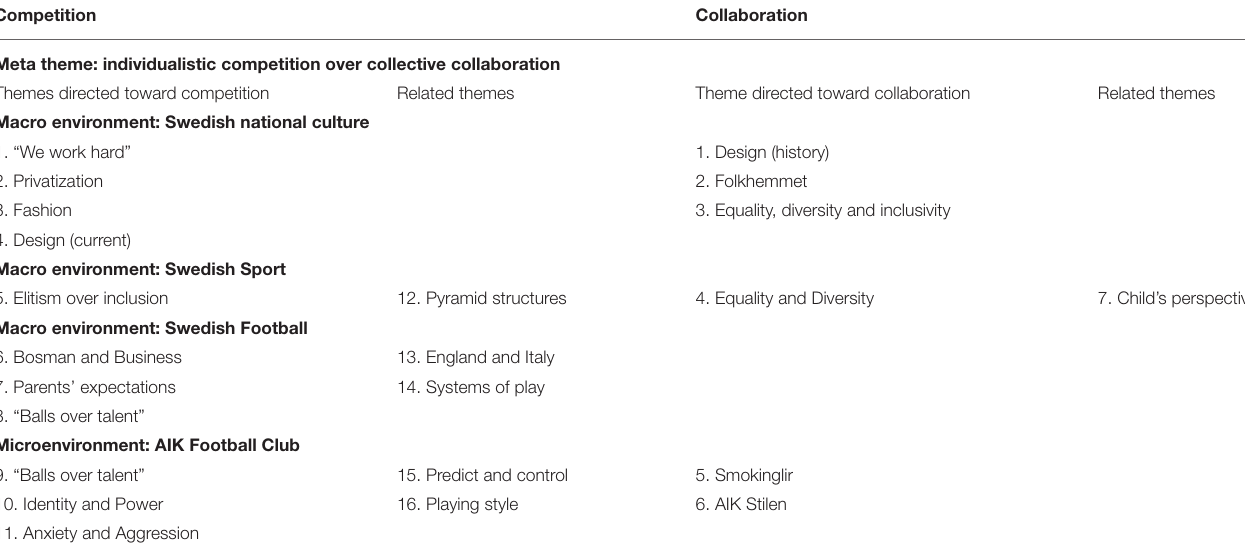
TABLE 1 | Key themes arising from ethnographic data under the meta theme individualistic competition over collective